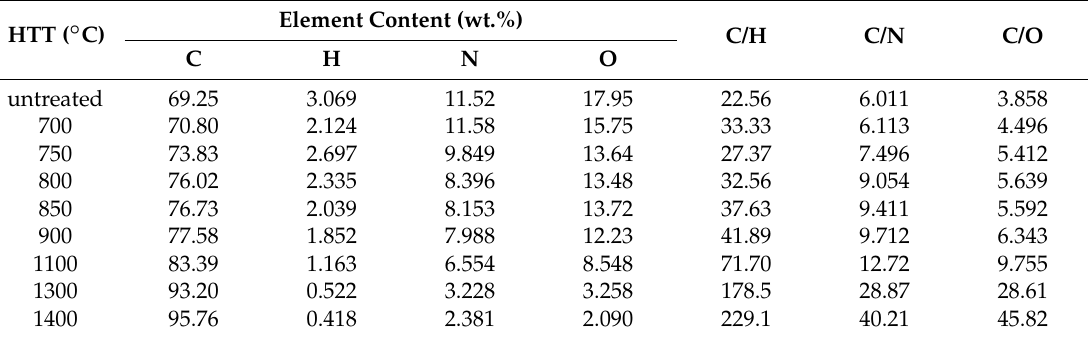
Table 2. Organic element analysis (OEA) results of carbonized